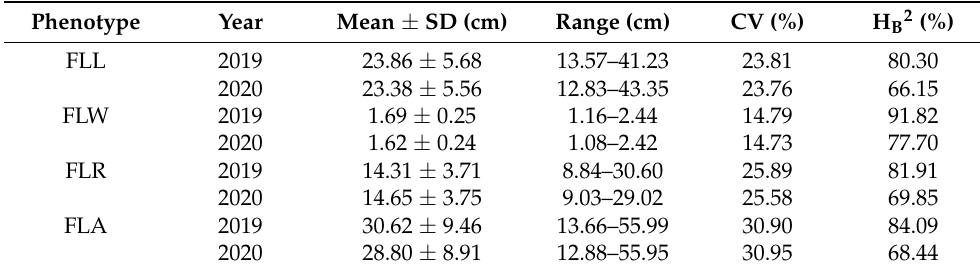
Figure 1. Phenotypes of flag leaf shapes in 10 rice accessions: ( a ) Flag leaf length; and ( b ) flag leaf width. Scale bar = 10 cm. Table 1. Descriptive statistics of flag leaf traits in 173 rice accessions.